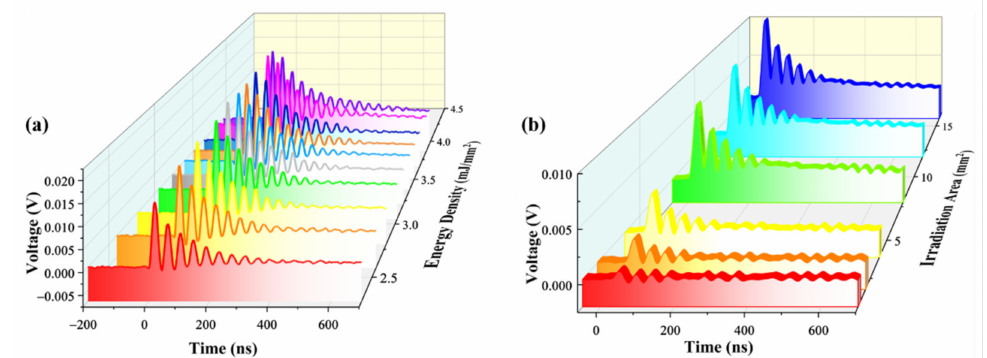
Figure 6. ( a ) LIV signal of pyrite under different laser energy densities from 2.3 to 3.96 mJ/mm 2 . ( b ) LIV signal with laser irradiation area of 1 mm 2 , 2 mm 2 , 4 mm 2 , 8 mm 2 , 12 mm 2 and 16 mm 2 , respectively.